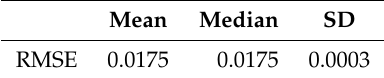
Table 4. RMSE obtained by the Random Forest algorithm to estimate the rate of use ( y i ) evaluated over the test data